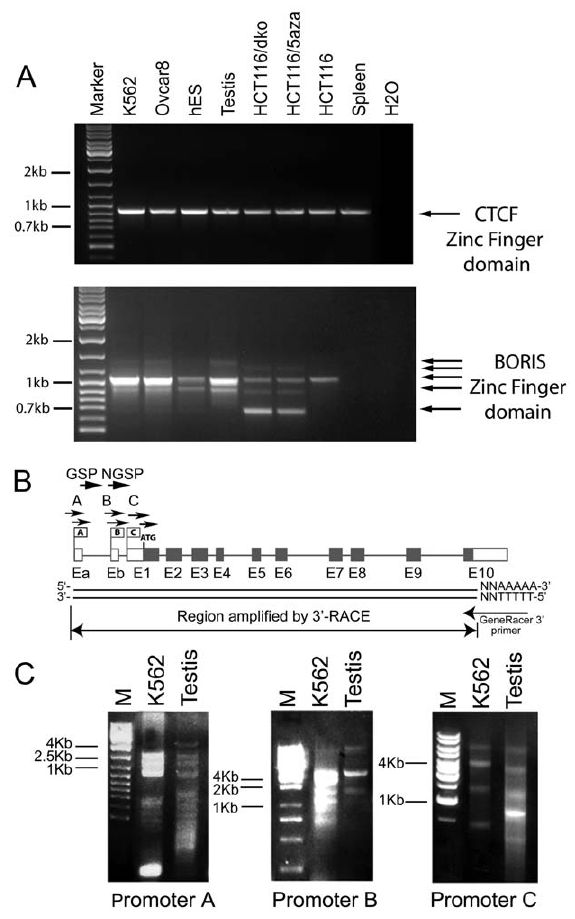
Figure 1. RT-PCR of alternatively spliced BORIS transcripts in human testis, ES cells and cancer cell lines. ( A ) Total RNAs from the indicated cell lines and testis tissue were analyzed by RT-PCR using primers designed to amplify the full-length CTCF and BORIS ZFs domains. The sequences of primers are shown in Table S1. Nested PCR was performed with 20 and 35 cycles for first and second rounds, respectively. The sources of RNA are shown on top of each gel. Arrows point to the single CTCF transcript and multiple BORIS alternative transcripts. ( B ) 3 9 RLM-RACE strategy for cloning alternatively spliced BORIS forms. Three BORIS alternative promoters and 12 exons with noncoding sequences (white boxes) or coding sequences (grey boxes) are shown. Total RNA from adult human testis and the K562 cell line was processed with GeneRacer PCR kit for the amplification of full- length cDNAs. The first round of PCR was performed with three forward gene-specific (GSP) primers A, B, and C that were designed to identify mRNA expressed from corresponding alternative BORIS promoters A, B or C, respectively. The 3 9 GeneRacer primer attached to the poly A tail was used as a reverse primer. l m l of the first-round PCR mixture was used as a template to perform nested PCR with three forward nested gene-specific (NGSP) primers A1, B1, and C1. ( C ) 3 9 RLM-RACE was performed on human testis and the K562 cell line. Multiple BORIS transcripts were detected in both samples. PCR products of the nested PCR are shown separated on 1% agarose gels. M is the size marker.